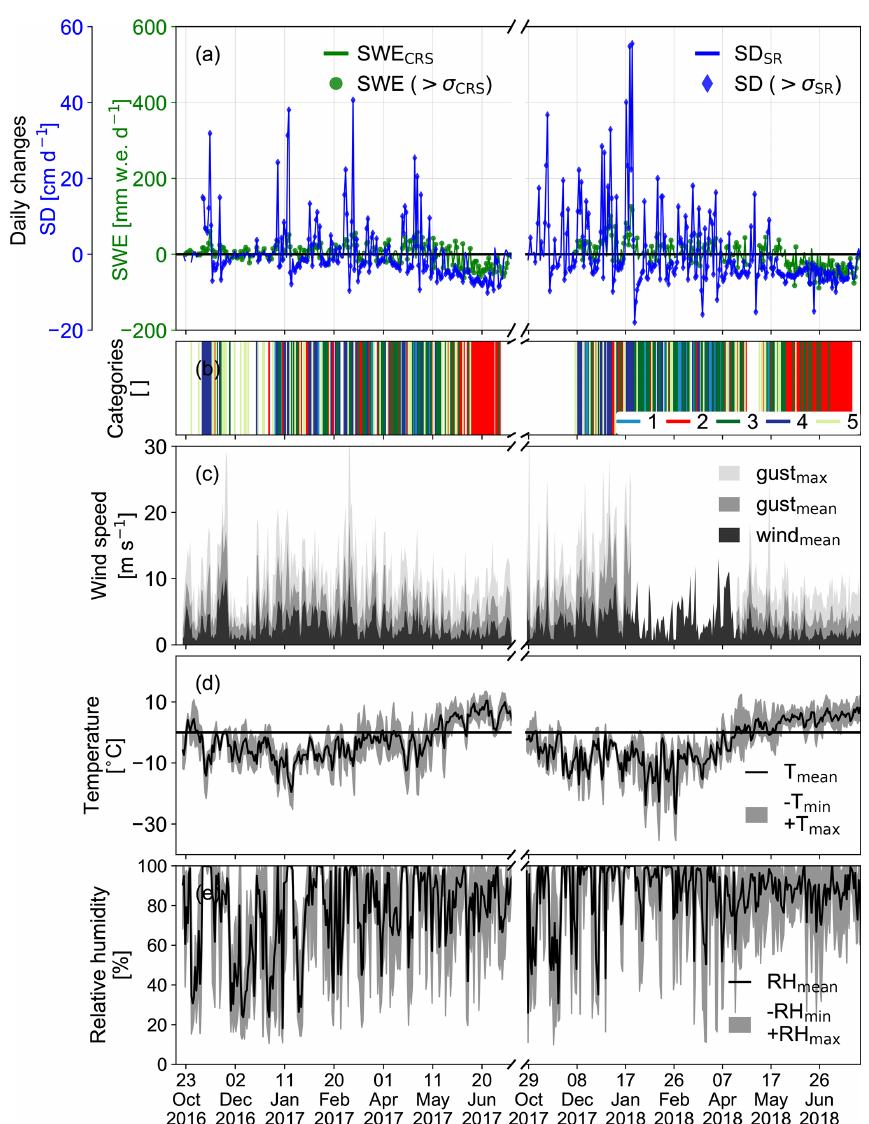
Figure 7. (a) Daily changes of SWE (green) and SD (blue). (b) Categorization of process-dominated days with 1 as accumulation, 2 as ablation, 3 as densification, 4 as accumulation with high confidence and 5 as densification with accumulation (see Table 6). (c) Daily mean wind speeds (black shading), mean wind gusts (grey shading) and maximum wind gust (light grey shading). (d) Daily mean temperature (black line) with maximum and minimum temperature (grey shading). (e) Daily mean relative humidity (black line) with daily minimum and maximum relative humidity (grey